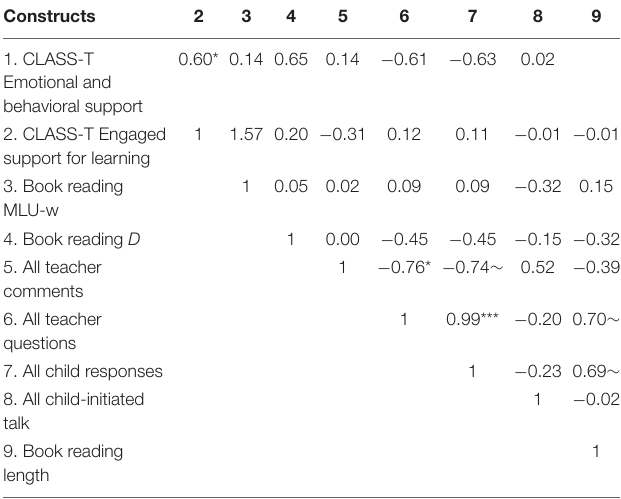
TABLE 5 | Correlations among